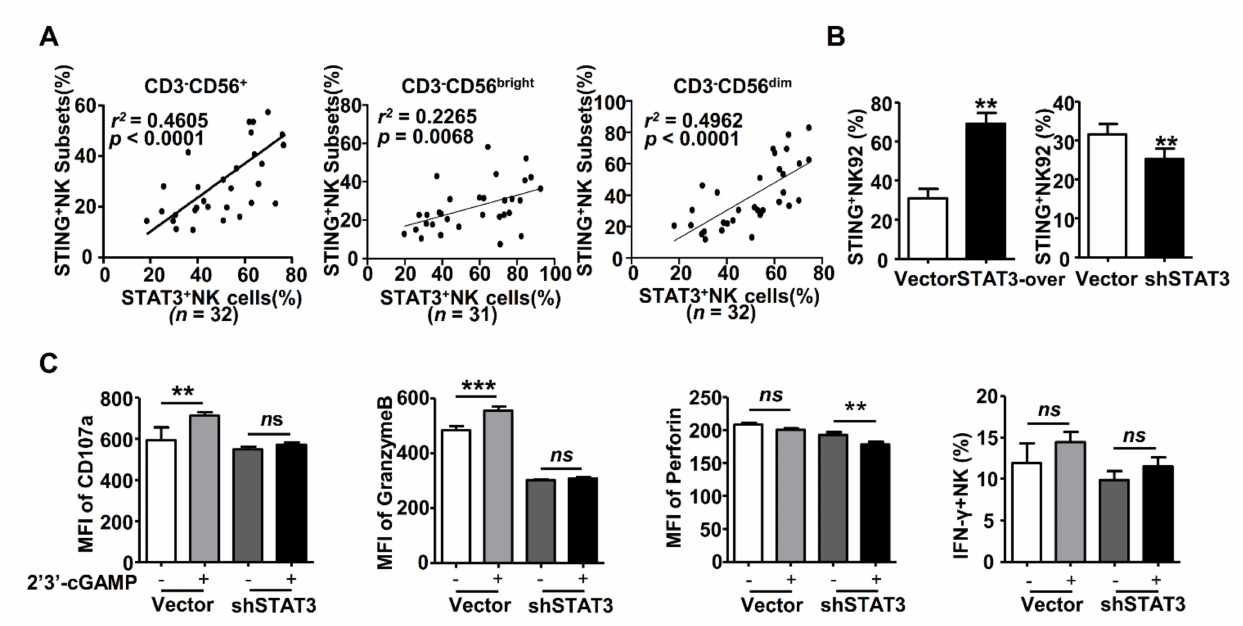
Figure 4. STAT3 regulated the expression and response of STING in NK cells. ( A ) The correlation between STING and STAT3 expression in the NK cells (CD3 - CD56 + , CD3 - CD56 bright and CD3 - CD56 dim cells) of CHB patients. ( B ) The levels of STING in STAT3-overexpressing and STAT3-knockdown NK-92 cells were analyzed by FACS. ( C ) CD107a and cytolysis markers’ expression in STAT3-knockdown or control NK-92 cells incubated with 2 (cid:48) 3 (cid:48) -cGAMP (10 µ g/mL) for 6 h. Data are shown as mean ± SEM from three independent experiments. The statistically significant difference between two groups was determined by a t -test and one-way ANOVA for multigroup analysis. The correlation between variables was analyzed by the Pearson coefficient. ns, p > 0.05; ** p < 0.01; *** p < 0.001. 0.04 < r 2 < 0.16, weak correlationship; 0.36 < r 2 < 0.64, strong correlationship. Vector, LMP or pCDH; shSTAT3, STAT3-knockdown NK-92 cells; STAT3-over, STAT3-overexpression NK-92 cells; NK, natural